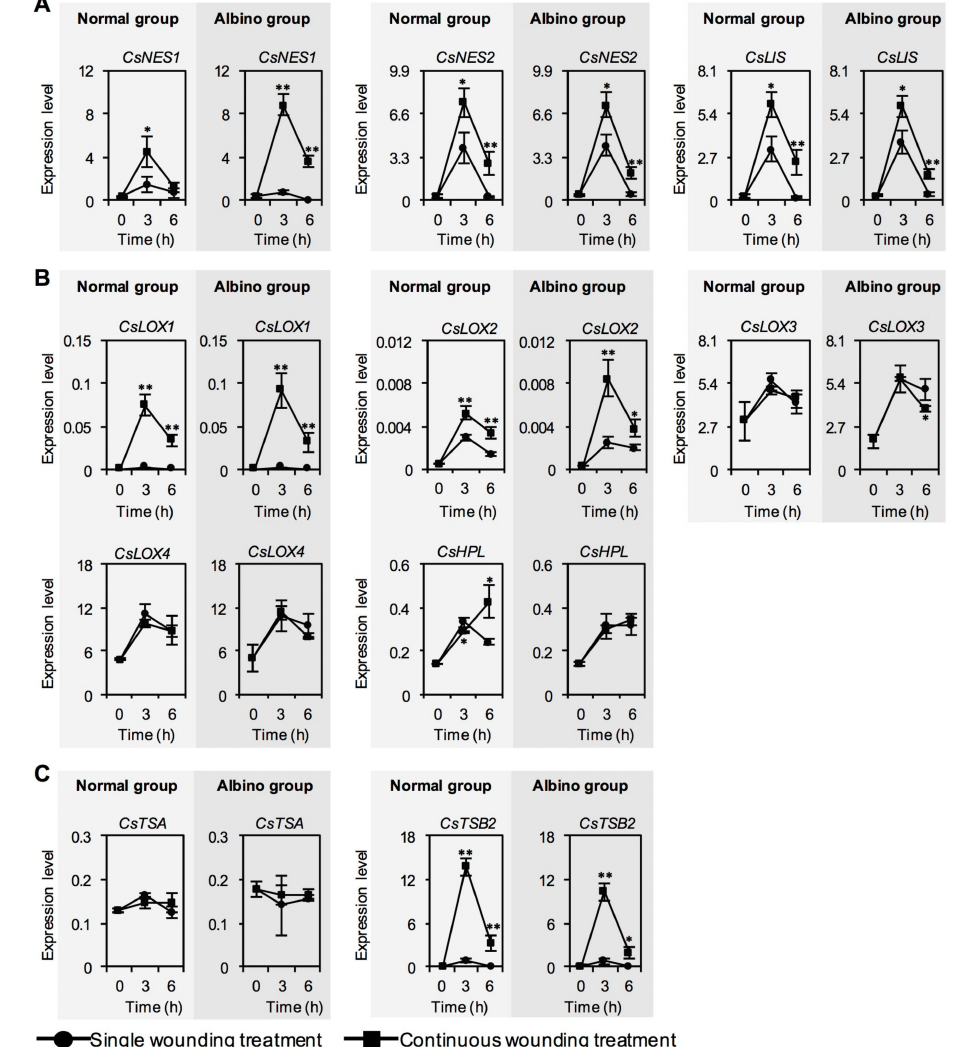
Figure 2. Changes in expression level of characteristic aroma compound biosynthetic genes of normal tea leaves and albino tea leaves exposed to single wounding treatment and continuous wounding treatment, respectively. Data are expressed as mean ± SD ( n =3). * p ≤ 0.05; ** p ≤ 0.01, comparison between single wounding treatment and continuous wounding treatment at the same treatment time. NES , (E)-nerolidol synthase ; LIS , linalool synthase ; LOX , lipoxygenase ; HPL , hydroperoxide lyase ; TSA , tryptophan synthase α -subunit ; TSB , tryptophan synthase β -subunit . ( A ) Genes involved in formations of volatile terpenes. ( B ) Genes involved in formations of volatile fatty acid derivatives. ( C ) Genes involved in formation of